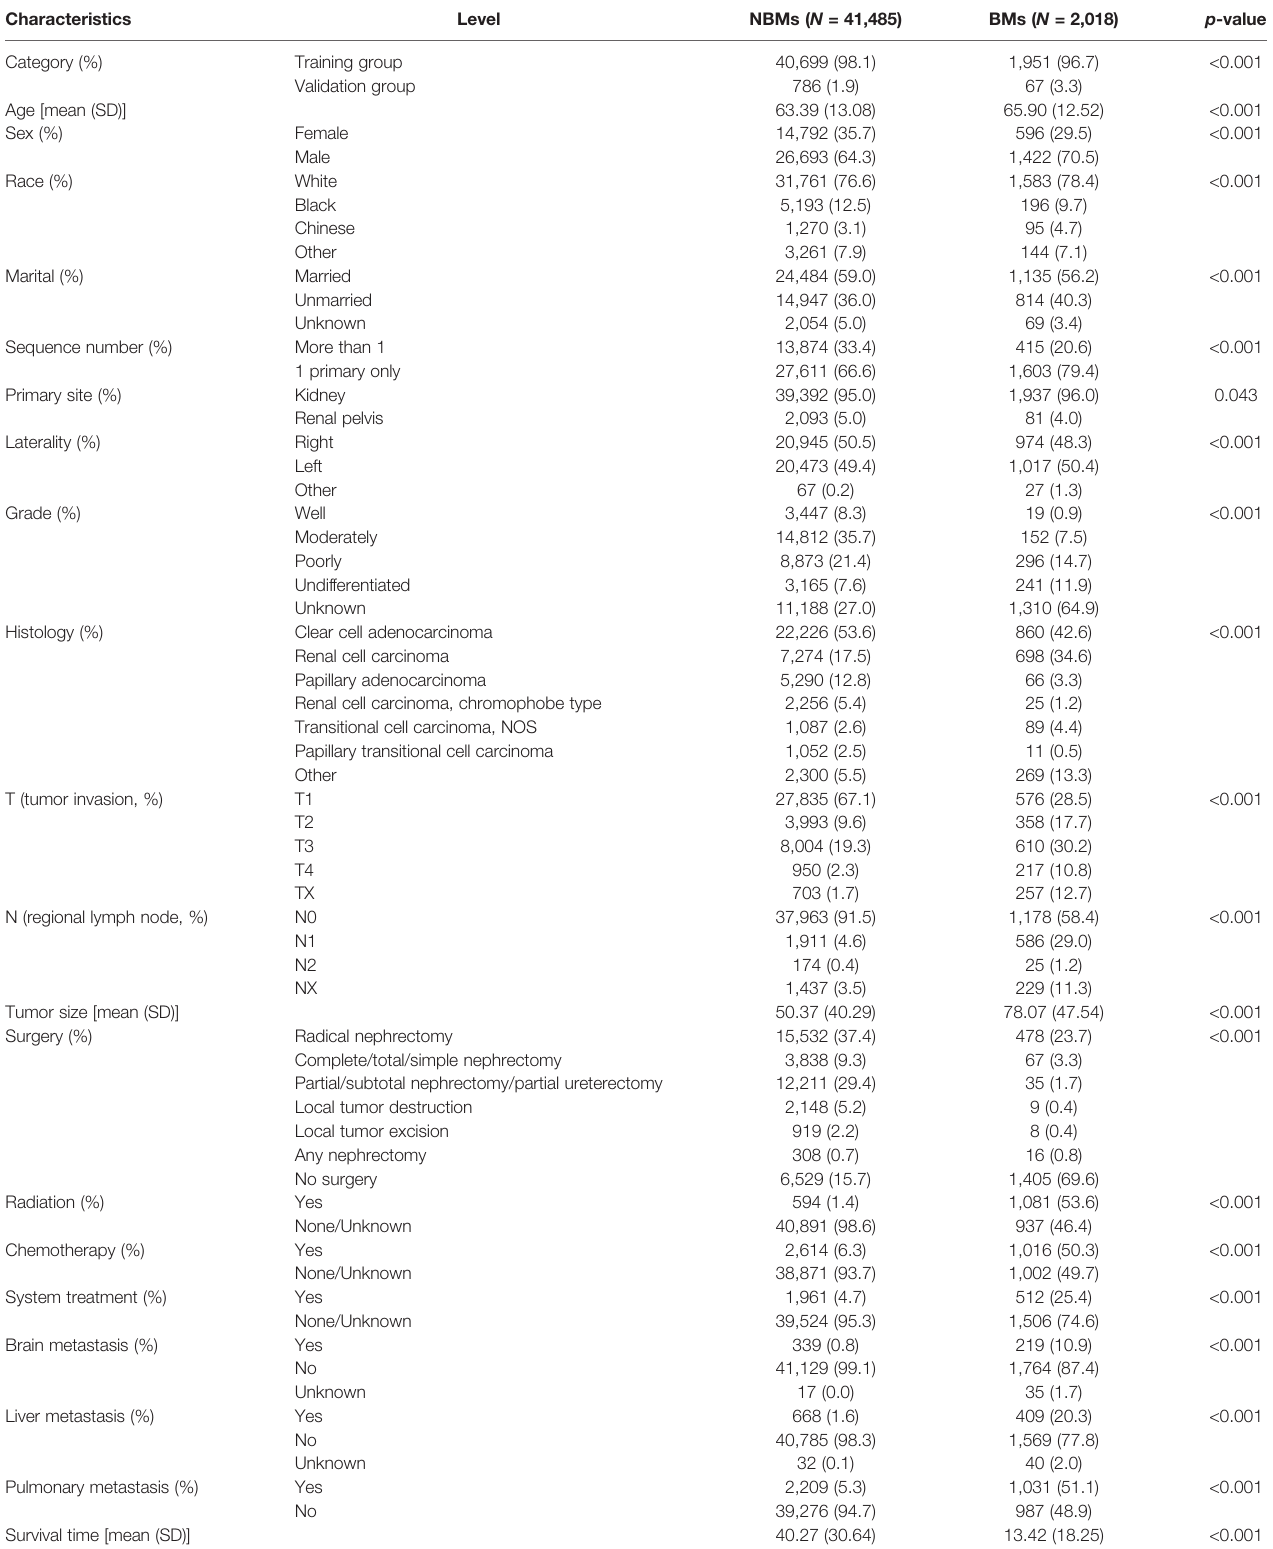
TABLE 2 | Comparison of patients with or without BMs.